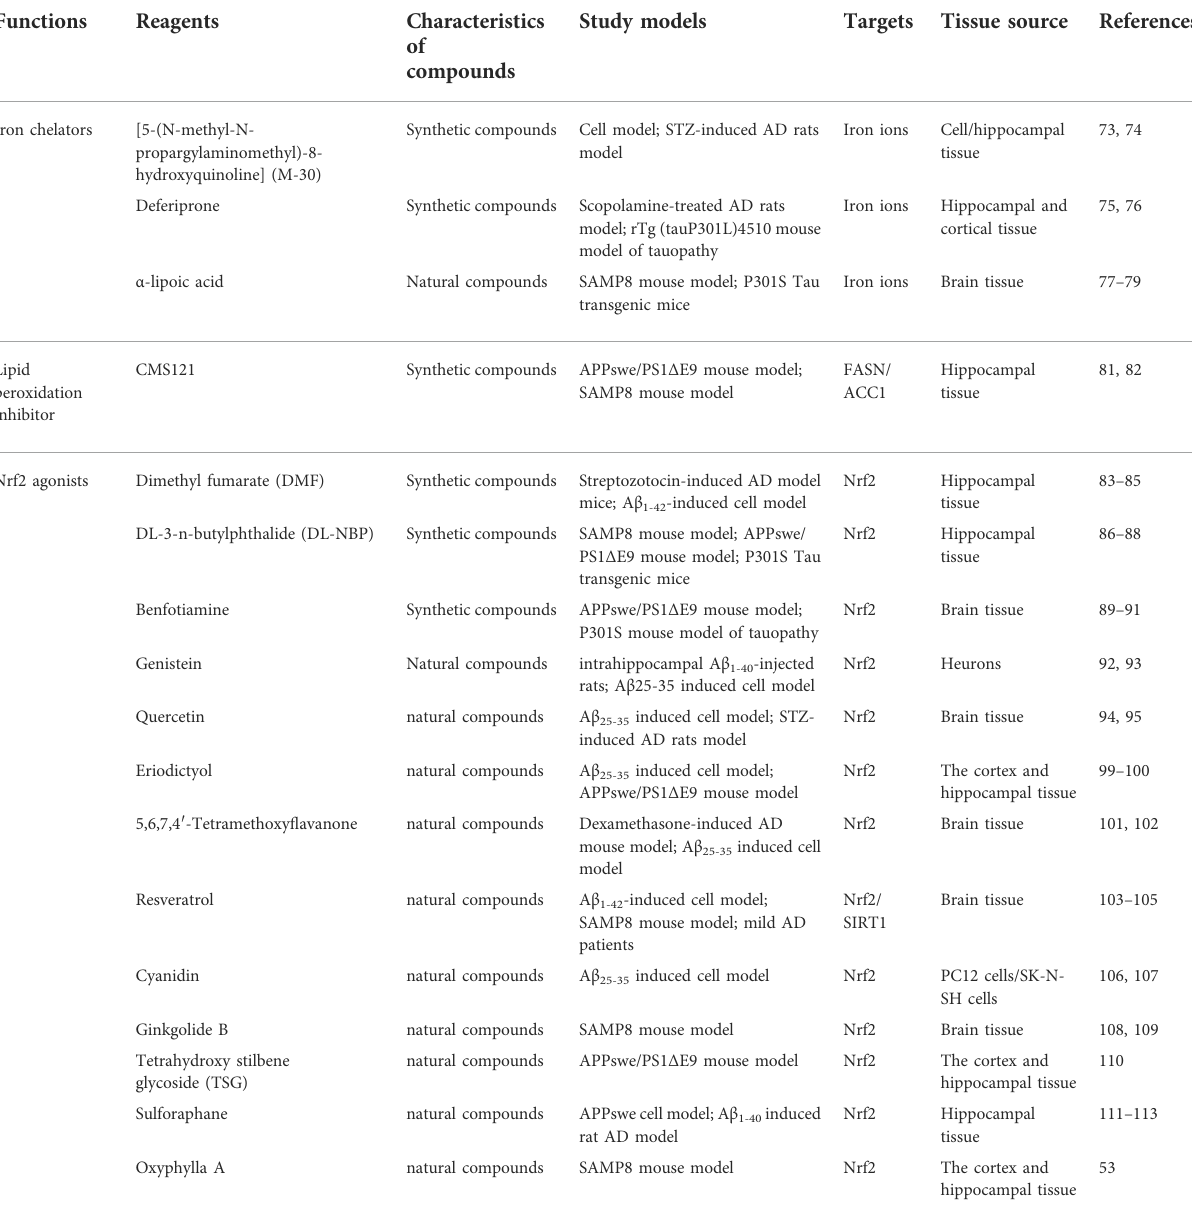
TABLE 1 Summary of novel ferroptosis inhibitors that have been studied in